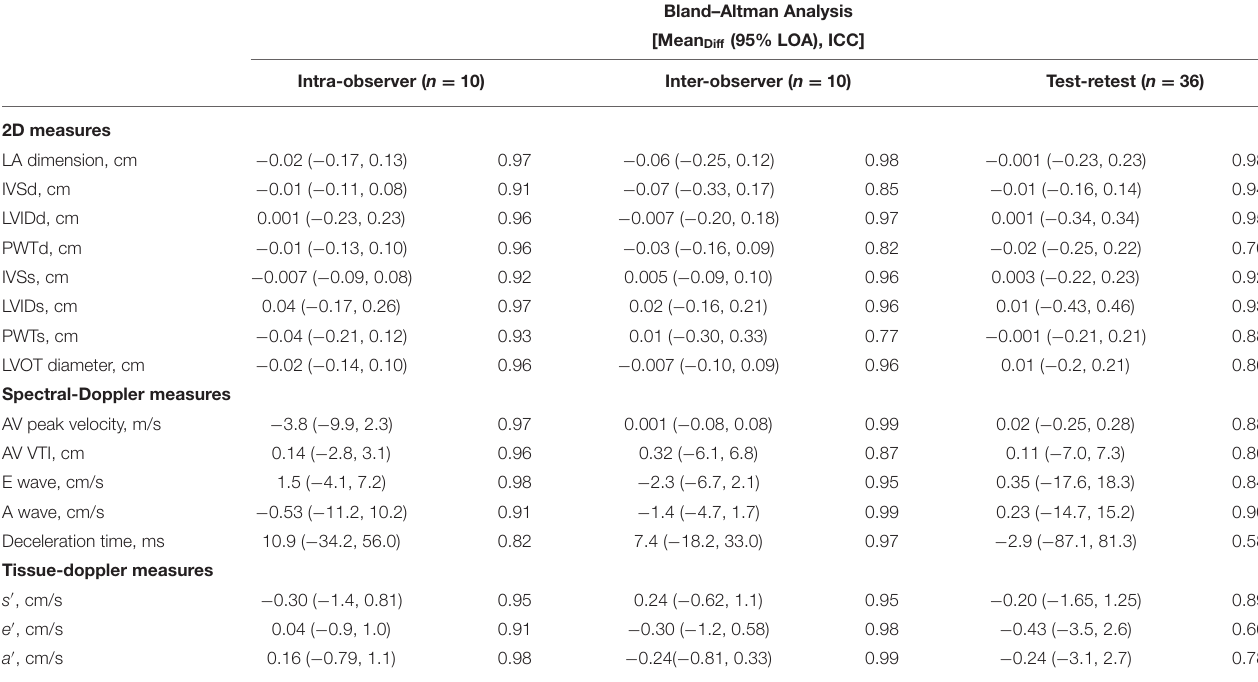
TABLE 5 | Reproducibility of conventional echocardiographic